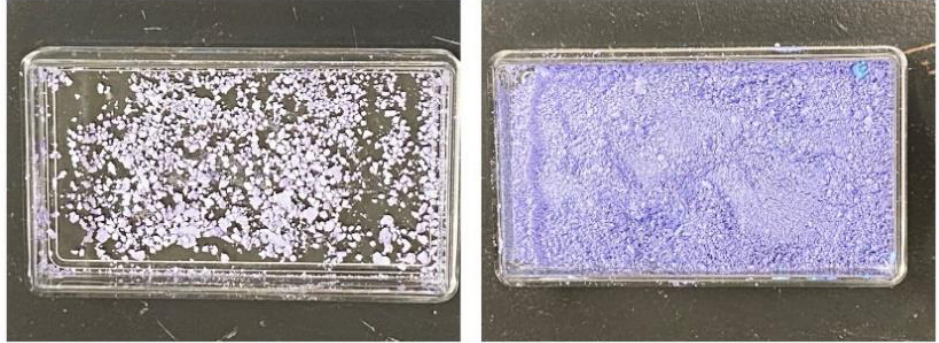
Figure 6. Appearance of OCP microspheres after immersion in the methylene blue solution ( Left ) and microspheres prepared with the addition of methylene blue ( Right ).